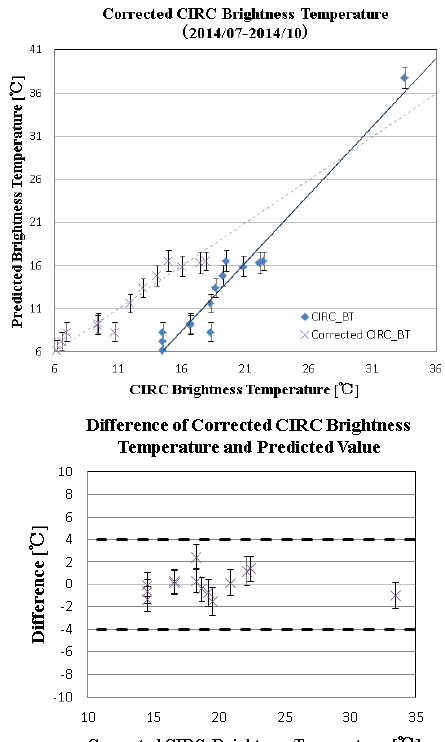
Figure 11. Corrected CIRC Brightness